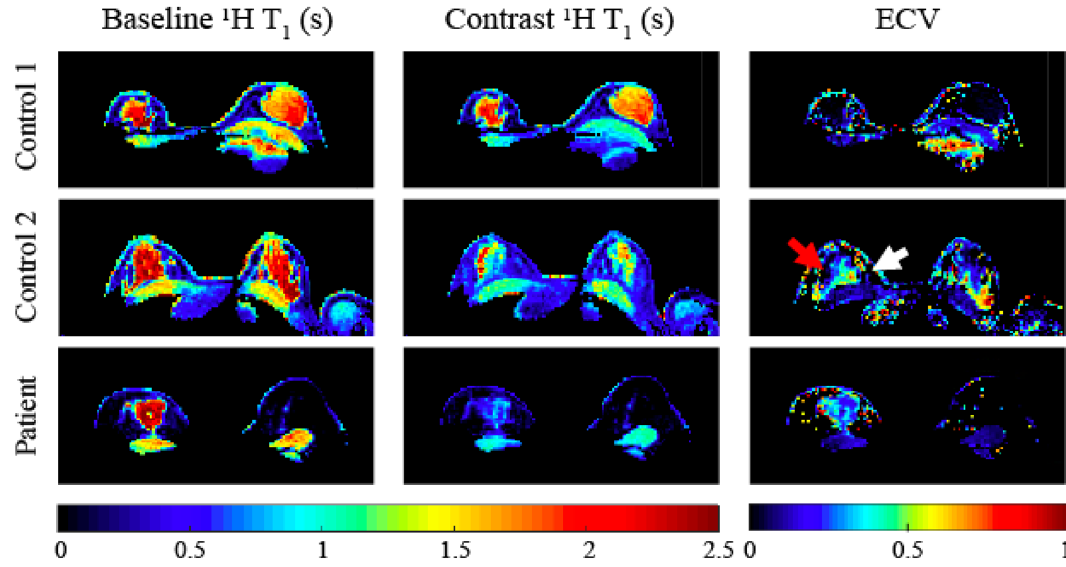
Figure 6. Baseline T 1 , post contrast T 1 and ECV in two healthy controls and a patient. In control 1 (top row) poor CA uptake with only 6% T 1 decrease and consequently extremely low average ECV (0.06 ± 0.10) were observed. In control 2 (center row) the average T 1 decrease in the fibrograndular tissue was 42% but with a non-uniform pattern, resulting in regions with higher ECV of 0.29 ± 0.24 (white arrows) where the uptake was greater, and regions with lower ECV of 0.03 ± 0.03 in regions with lower uptake. The T 1 decrease in the lesion of a 51-years-old triple negative breast cancer patient (bottom row) was 67% which resulted into mean ECV in the lesion of 0.28 ± 0.12.